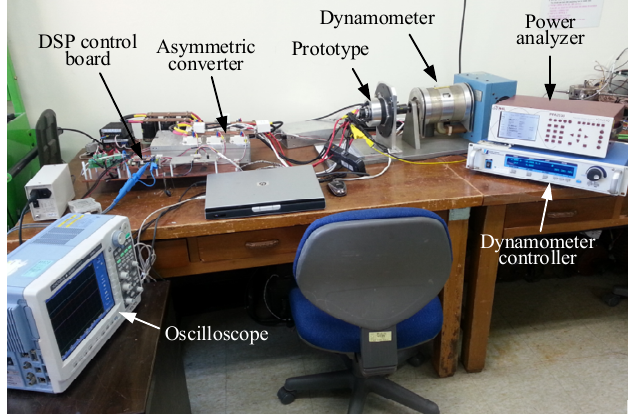
Figure 16. Test platform for the two motors.